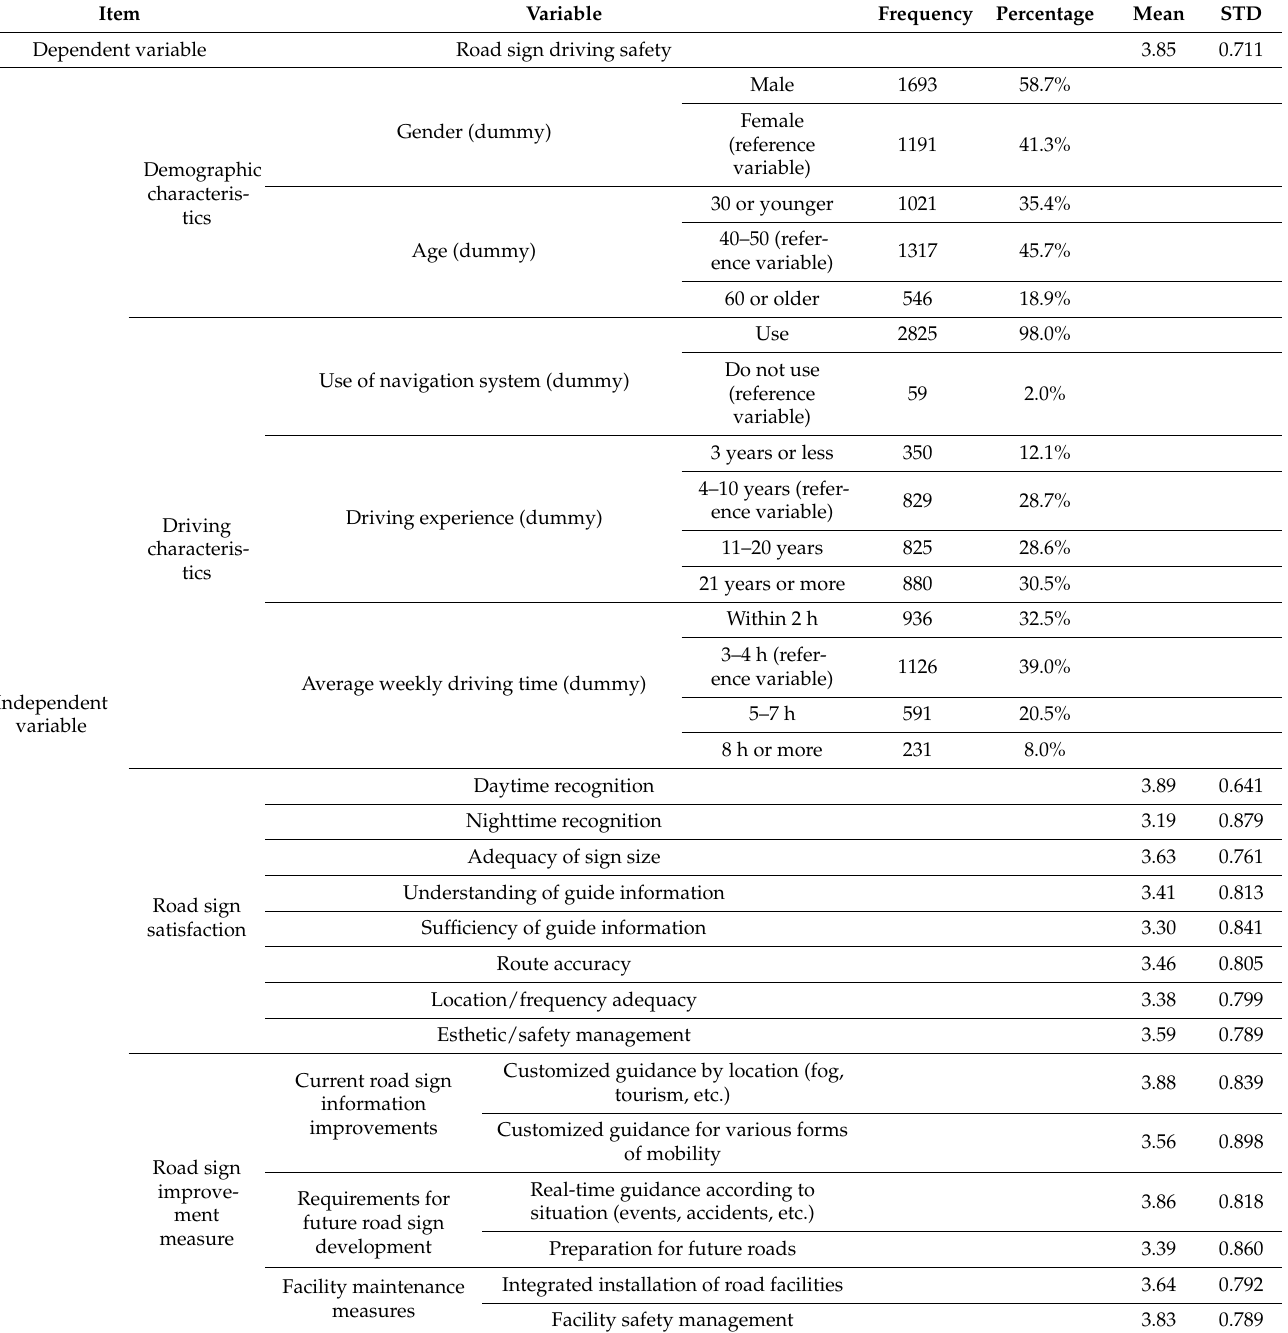
Table 5. Variable